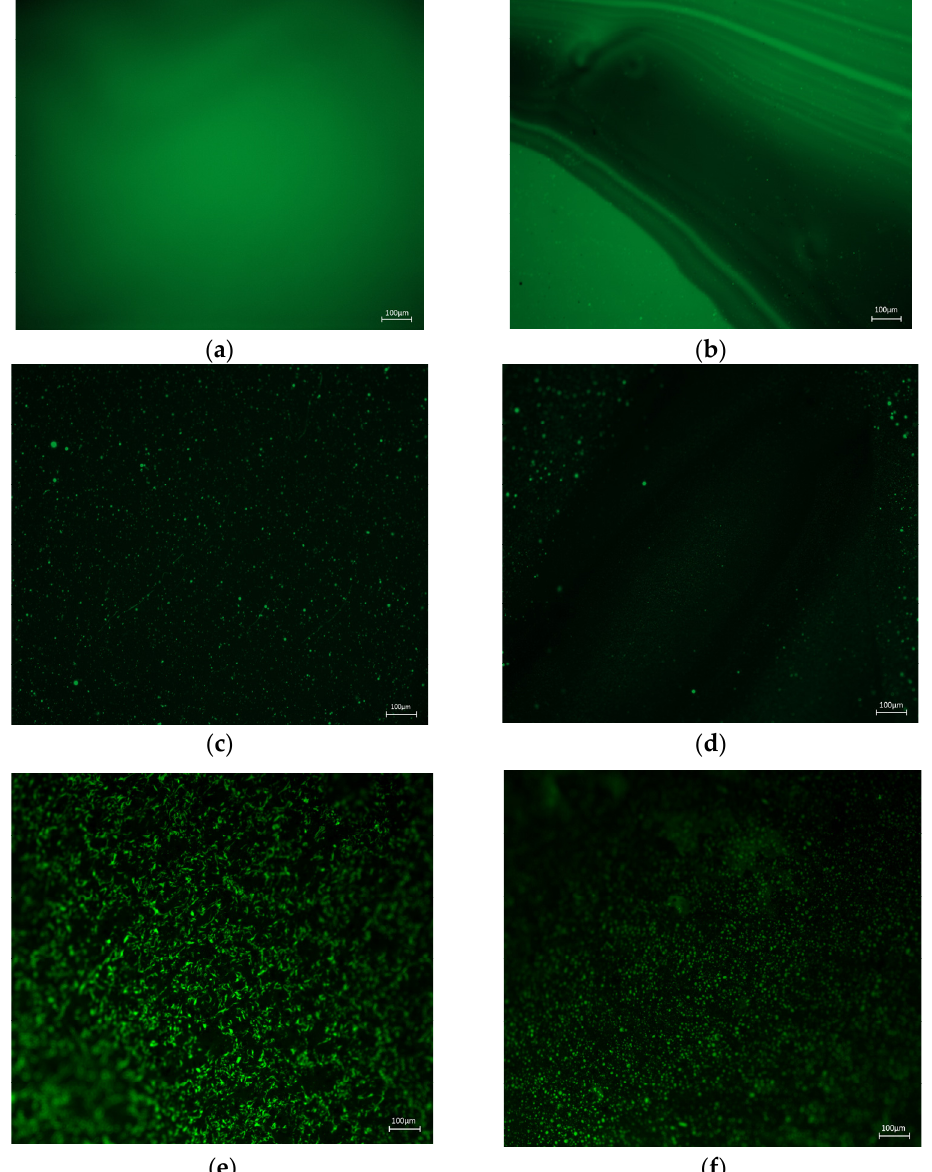
Figure 18. Microscopic images of three kinds of asphalt fluorescence before and after oil corrosion: ( a ) Matrix asphalt fluorescence microscopy; ( b ) Oil corrosion matrix asphalt fluorescence microscopy; ( c ) 4.5% SBS modified asphalt fluorescence microscope; ( d ) Oil corrosion 4.5% SBS modified asphalt fluorescence microscope; ( e ) 2.3% ER/3.8% SBS fluorescence microscopy; ( f ) Oil corrosion 2.3% ER/3.8% SBS fluorescence microscope.